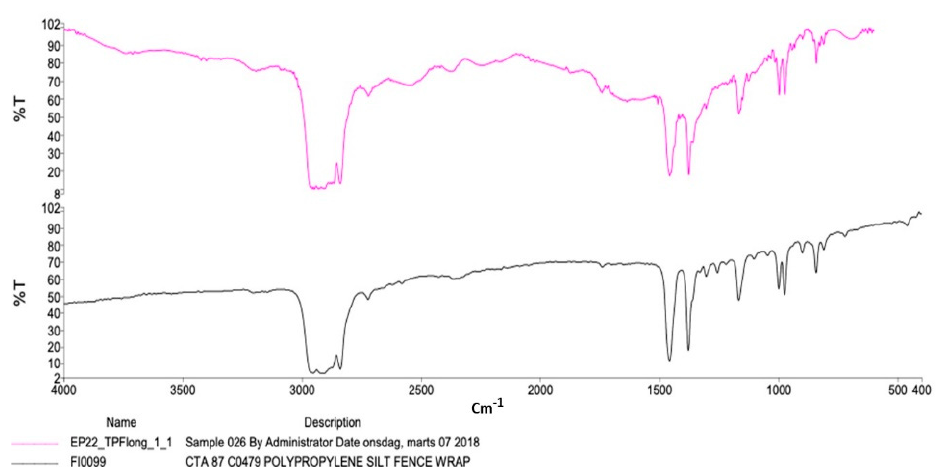
Figure 3. FTIR spectra of a polypropylene line sampled during the expedition (purple spectra). All samples were compared with a reference library developed over several years, containing both pristine spectra and spectra from samples of plastic collected in marine, freshwater, and terrestrial environments in Europe, Africa (including coastal waters), the Atlantic Ocean, and the Pacific Ocean (black spectra).